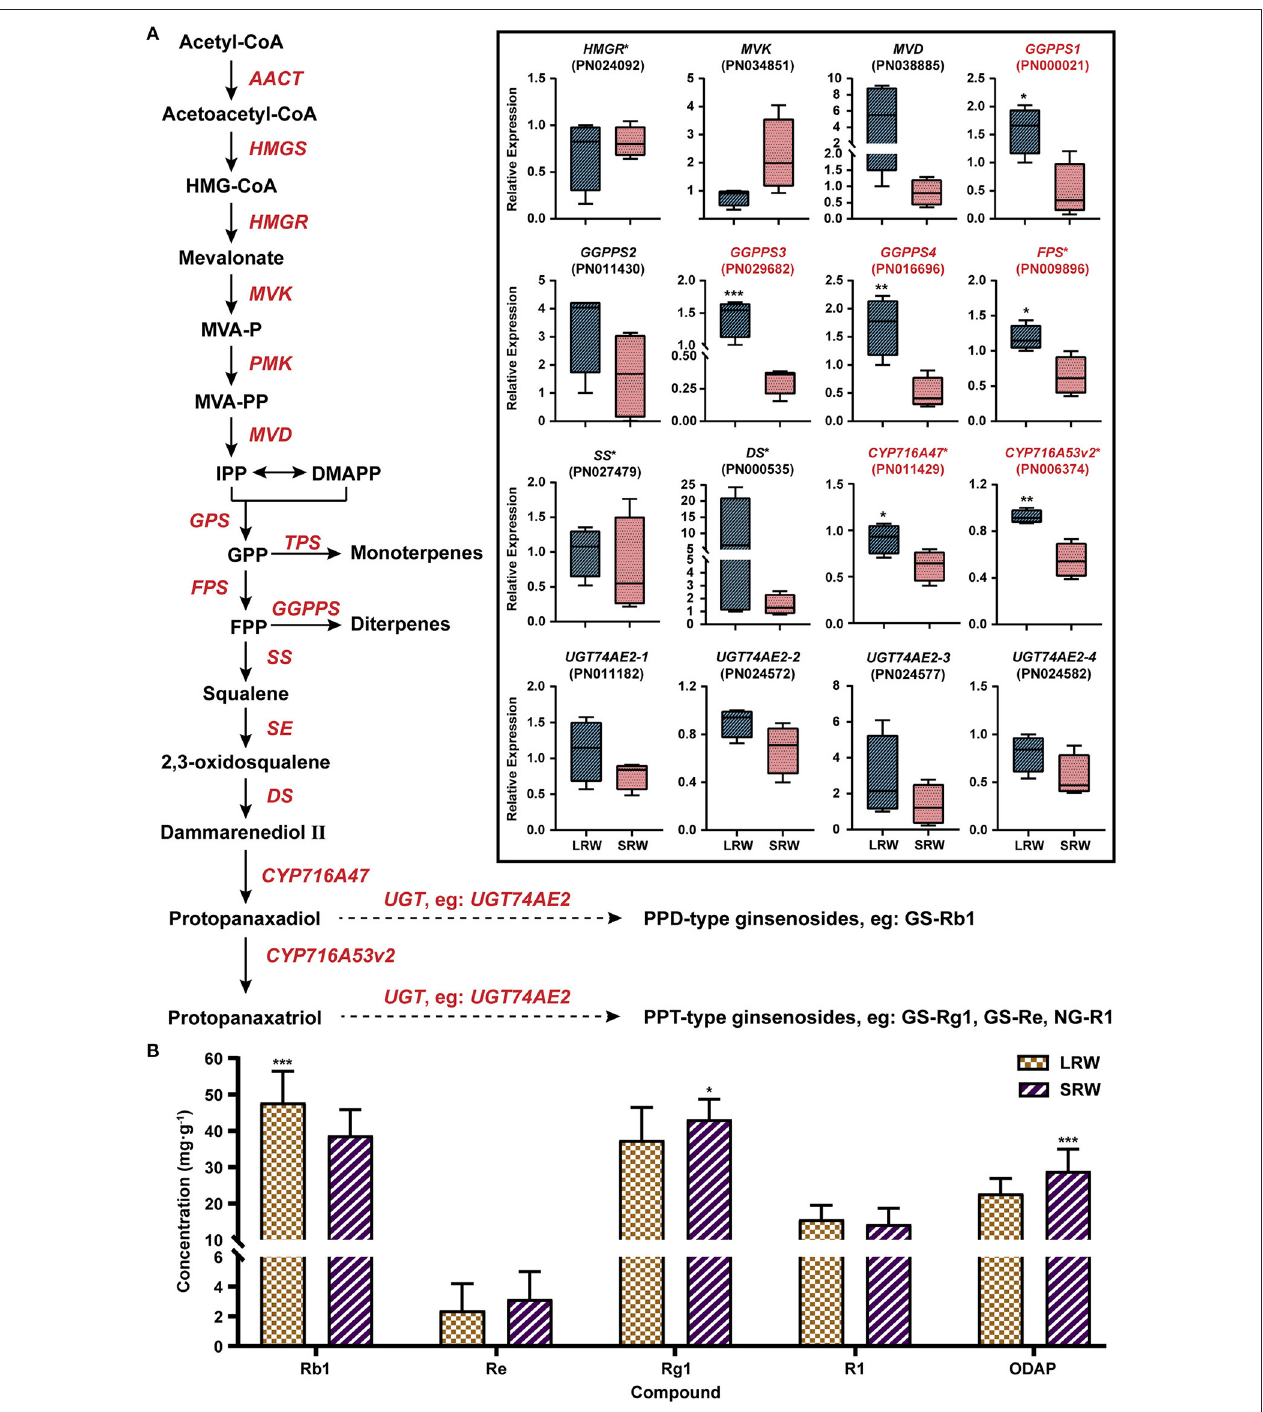
FIGURE 4 | Expression pattern of genes related to biosynthesis of ginsenosides and content of active components. (A) Expression pattern of genes related to biosynthesis of ginsenosides in LRW and SRW groups. (B) Content of active components in LRW and SRW groups. AACT, acetyl-CoA C-acetyltransferase; HMGS, hydroxymethylglutaryl-CoA synthase; HMG-CoA, 3-hydroxy-3-methylglutaryl CoA; HMGR, hydroxymethylglutaryl-CoA reductase; MVK, mevalonate kinase; MVAP, mevalonate-5-phosphate; PMK, phosphomevalonate kinase; MVAPP, mevalonate-5-pyrophosphate; MVD, diphosphomevalonate decarboxylase; IPP, isopentenyl diphosphate; DMAPP, dimethylallyl diphosphate; GPS, geranyl pyrophosphate synthase; GPP, geranyl pyrophosphate; FPS, farnesyl diphosphate synthase; FPP, farnesyl diphosphate; GGPPS, geranylgeranyl pyrophosphate synthase; SS, squalene synthase; SE, squalene epoxidase; DS, dammarenediol-II synthase; CYP, cytochrome P450 proteins; UGT, UDP-glycosyltransferase; GS, ginsenoside; NG, notoginsenoside. Genes obtained * on upper right were reported to be functional. Genes in red tag had statistical significance. Asterisks denote Student’s t -test significance: * P < 0.05, ** P < 0.01, and *** P < 0.001.